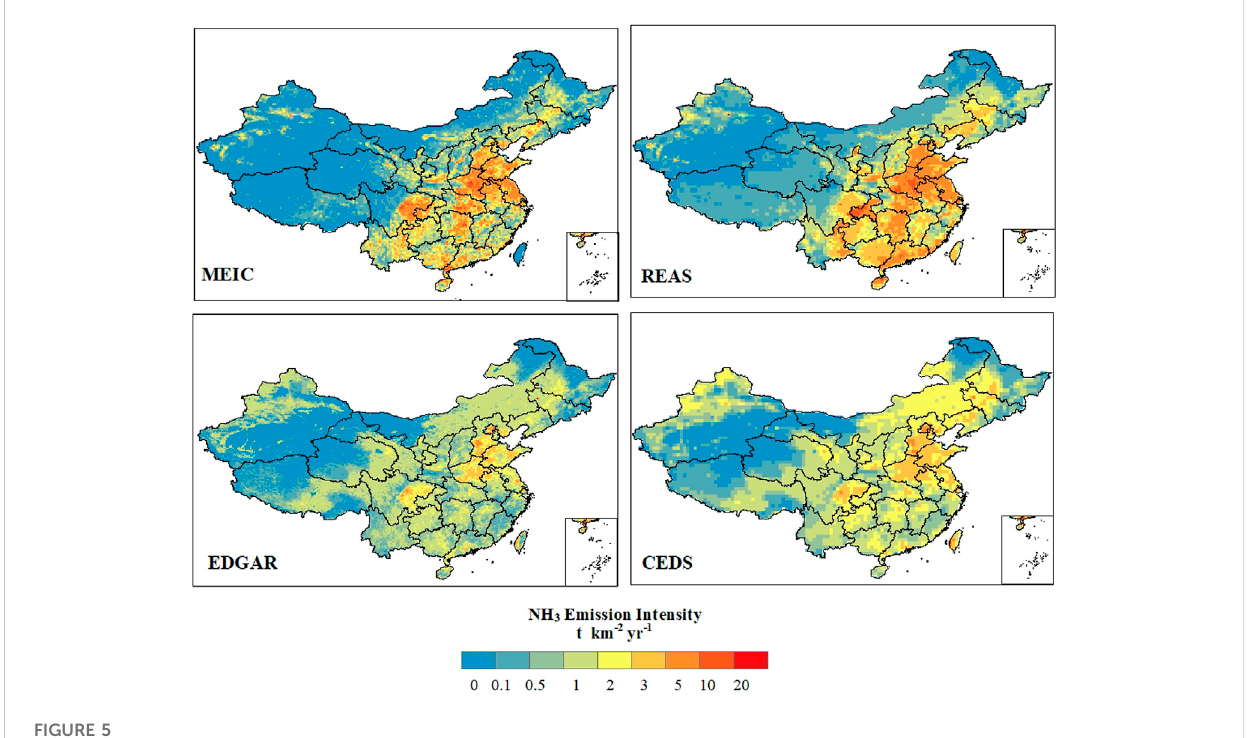
FIGURE 5 Spatial distribution of gridded NH 3 emissions in 2015 from China.